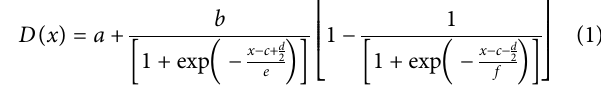
Frontiers in Pharmacology |